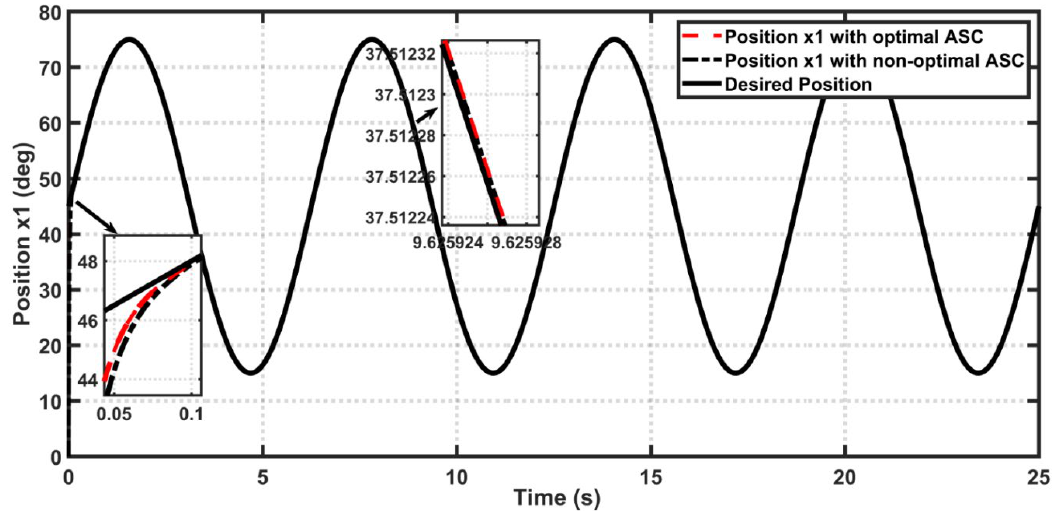
Figure 8. The behaviours of knee angular positions based on non-optimal and optimal ASC.